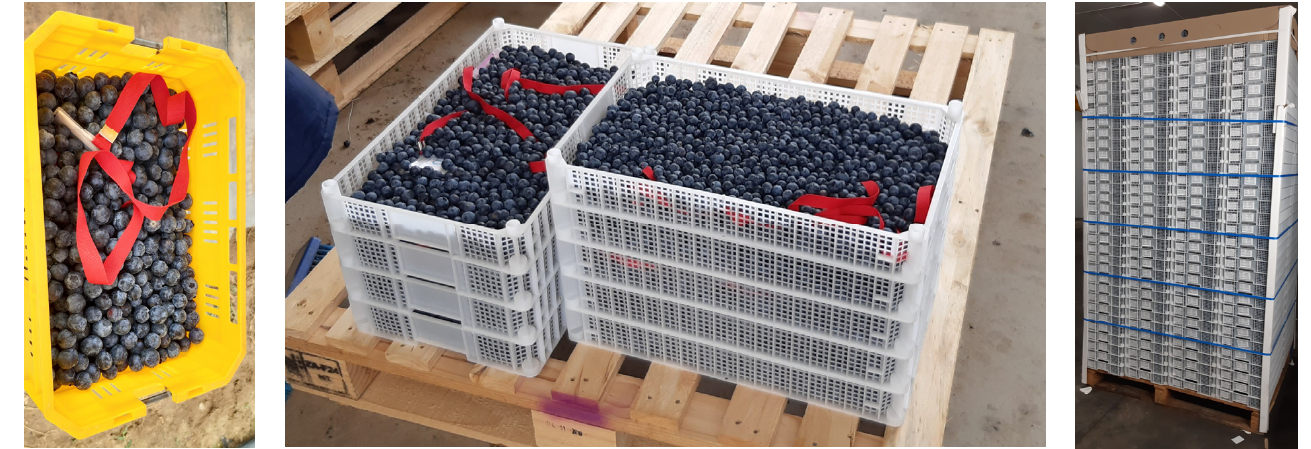
Figure 5. iButtons ® in lugs during harvest, iButtons ® in trays at QC tables, and a completed pallet . Source: [13].